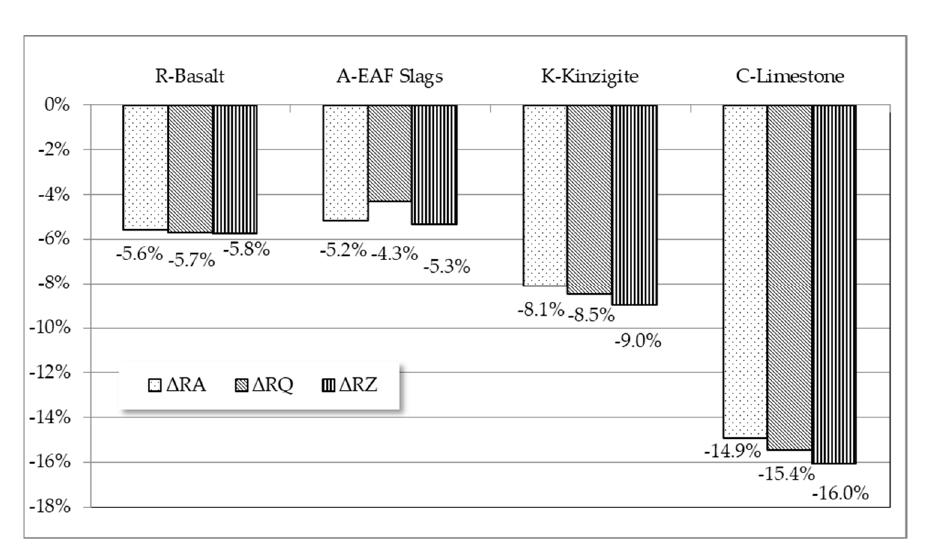
Figure 7. Average Δ R i for each aggregate after polishing. Figure 7. Average ∆ R i for each aggregate after